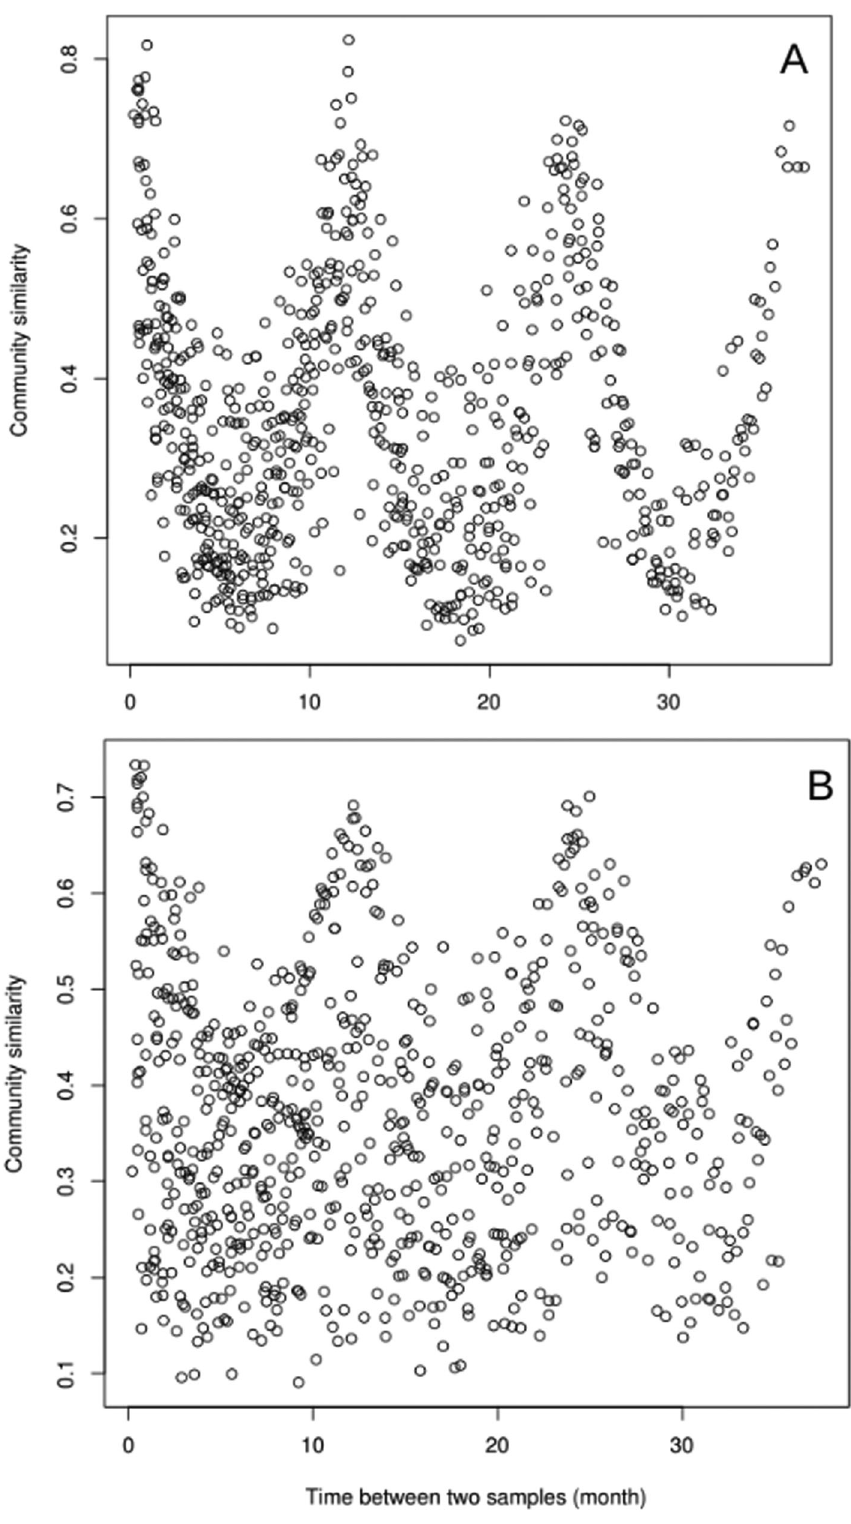
Fig. 2 Pairwise comparisons of similarity between communities in relation to the time separating two samples. The similarity was measured by a direct metagenome-to-metagenome comparison of the read content for the unassembled ( A ) and assembled ones ( B